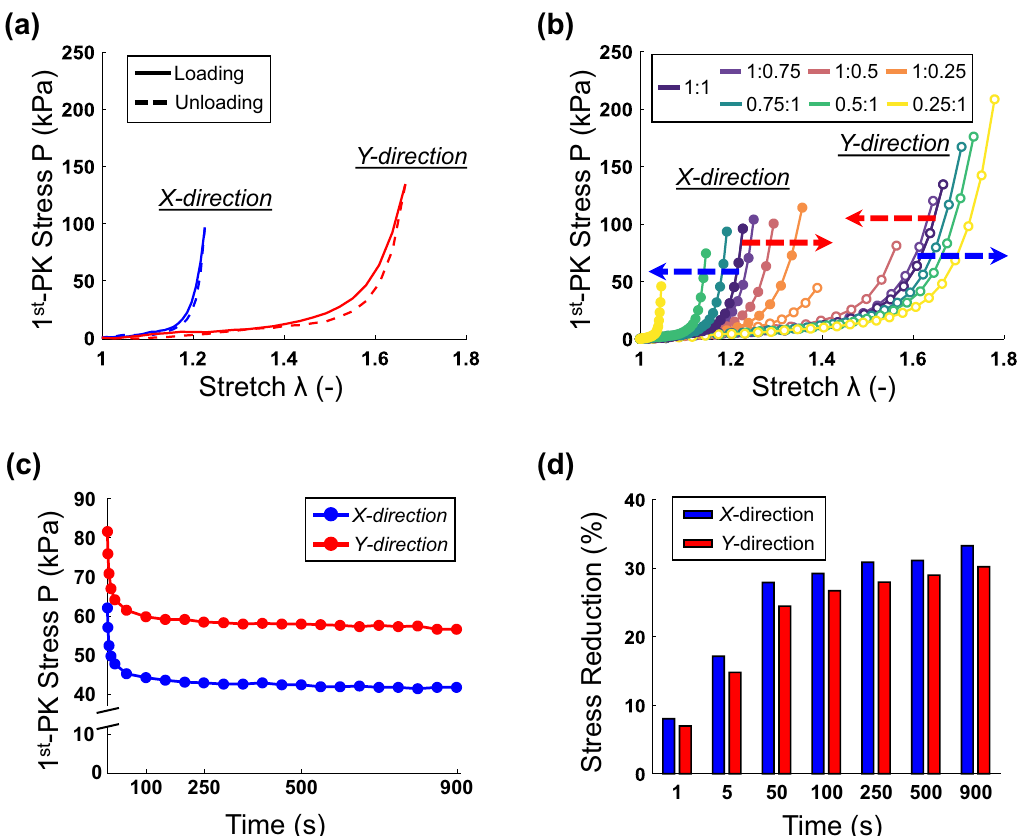
Figure 2. Biaxial mechanical results of ( a ) the loading and unloading cycles of the equibiaxial tension protocol ( F X : F Y = 1 : 1 ), ( b ) complete in-plane biaxial protocols, ( c ) stress relaxation protocol, and ( d ) percent stress reduction in stress